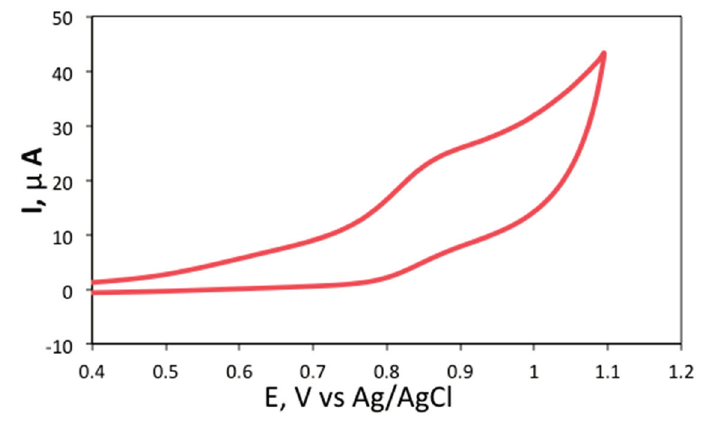
Figure 5. Cyclic voltammogram of RuNP modified screen-printed carbon electrode surface in 0.1 M phosphate buffer, pH 7.5. Conditions: potential was swept at 0.01